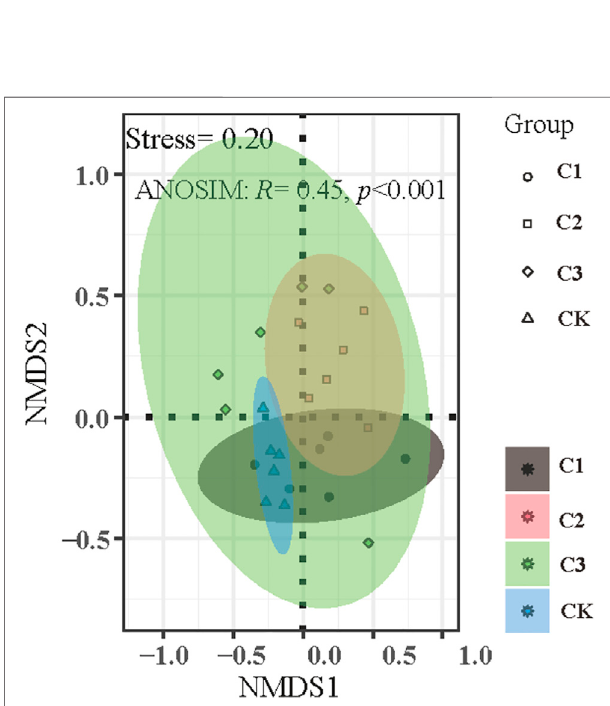
FIGURE 4 | Non-metric multidimensional scaling plot of soil nematode community assemblage exposed to varying magnitudes of microplastic pollution. CK: no microplastics added to the soil; C1:75 g of microplastics added to the soil (0.5%, w/w); C2: 150 g of microplastics added to the soil (1%, w/w), and C3: 300 g of microplastics added to the soil (2%,